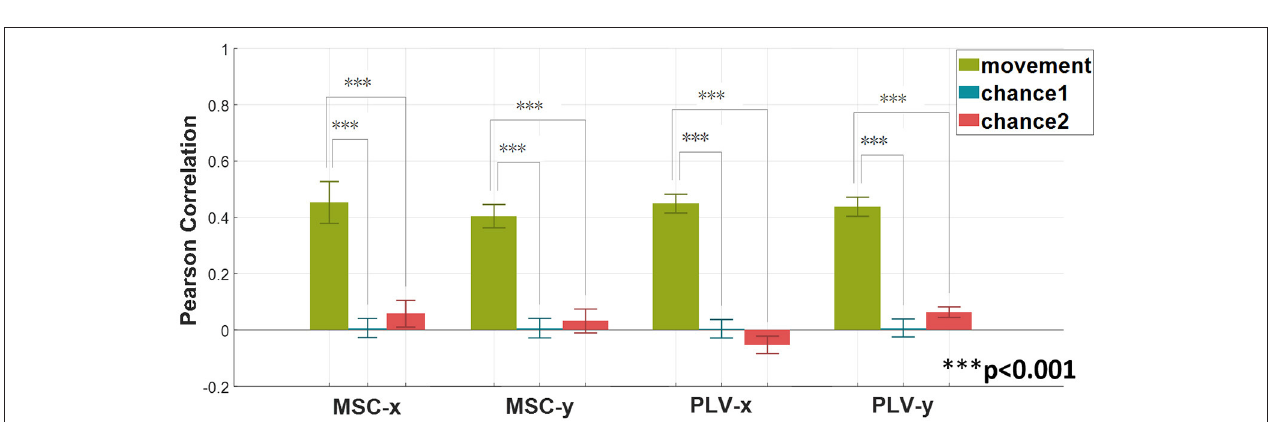
FIGURE 5 | Verifying the statistical significance of the proposed method with MSC and PLV features as regression predictors via Wilcoxon rank-sum test. Two surrogate methods are used for calculating chance levels. The method denoted by chance1 is based on shuffling the target response. The second method indicated as chance2 is based on shuffling EEG signals. The above graph shows the average (mean ± SD) results over all subjects (Wilcoxon rank-sum test, *** p <